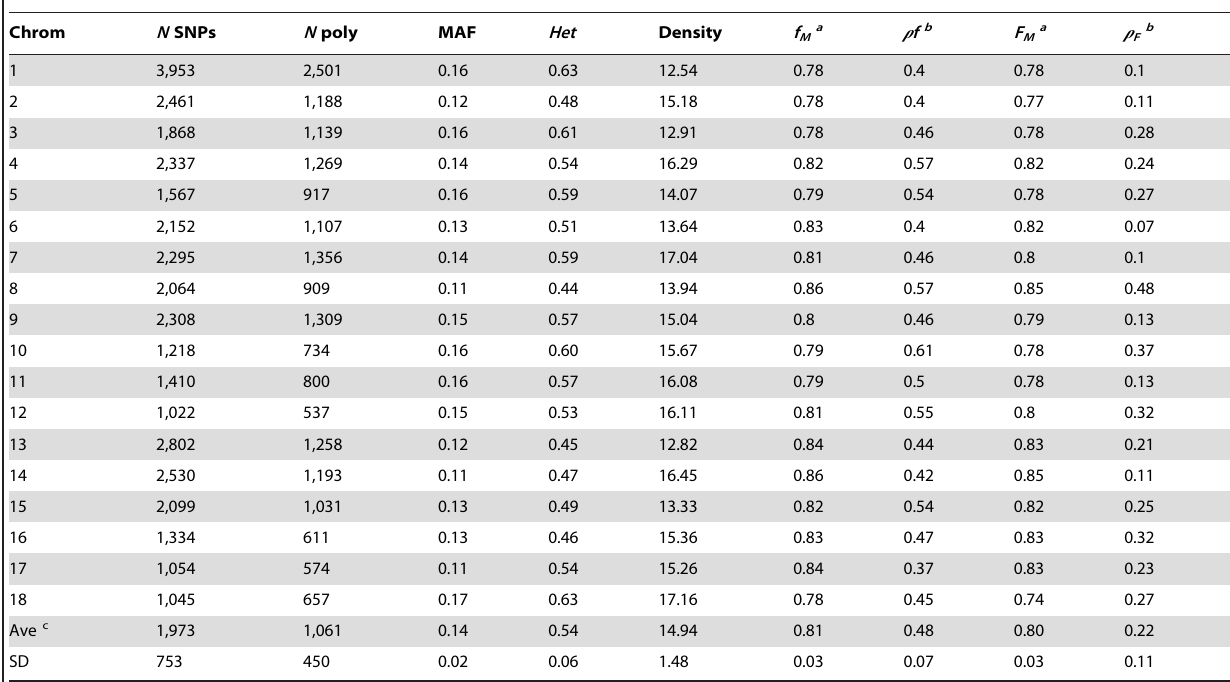
Table 1. Summary statistics of SNPs across chromosomes.